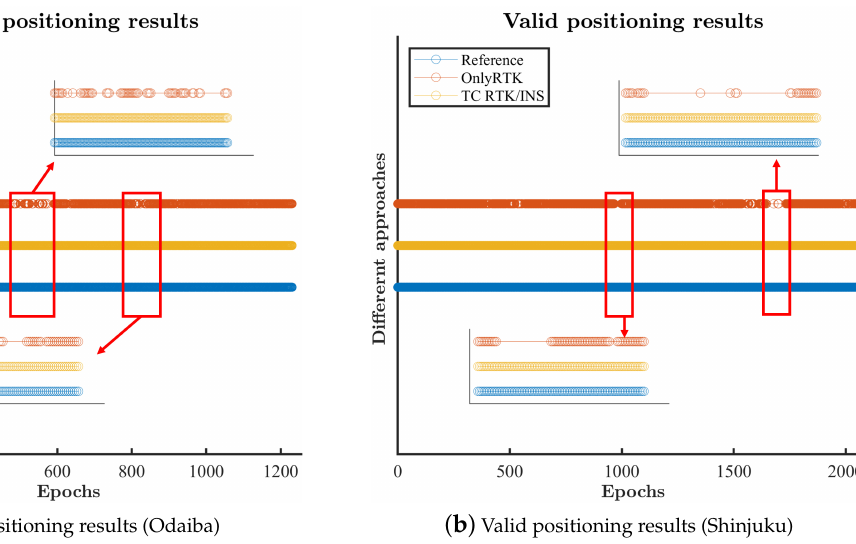
Figure 6. The number distribution of preprocessed DD measurements.